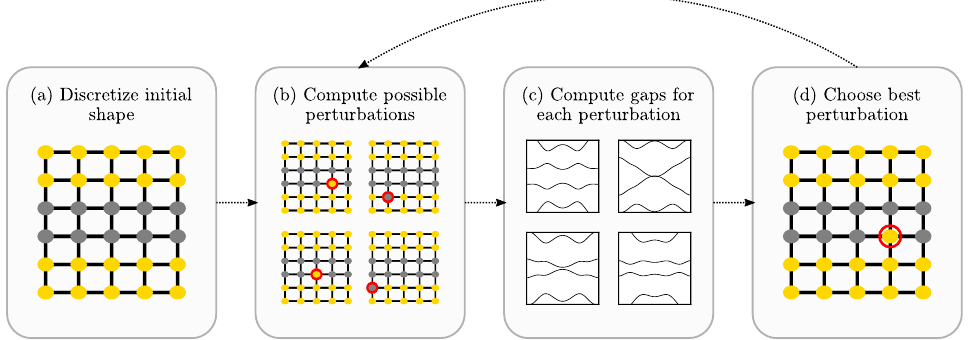
Figure 2: Summary of the core optimization algorithm. (a) We start from a dis- cretized model of the junction. (b) At the start of an iteration we determine the boundaries of each superconductor. We then consider perturbations that introduce or remove superconductivity in sites at the boundary (circled in red). (c) Using per- turbation theory, we compute how the gap changes with each geometry modifica- tion. (d) Finally, we update the shape using the modification that yields the largest improvement in the